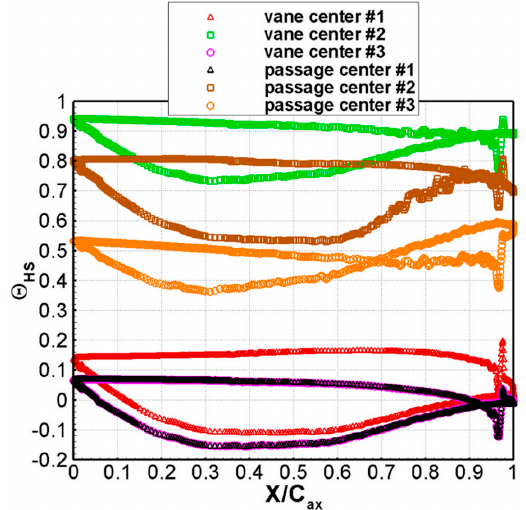
Figure 10. Predicted temperature ratio ( Θ HS ) around each vane at midspan ( Z/H = 0.5) for the hot streak aligned with the vane or passage center.